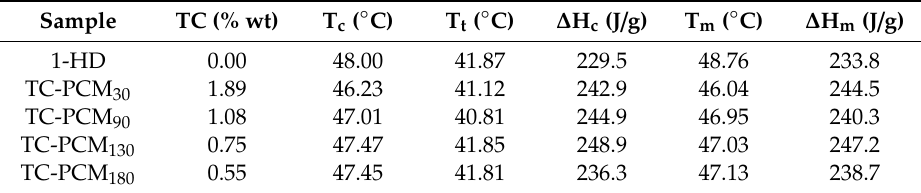
Table 1. Thermal date of TC-PCMs and pure 1-HD.